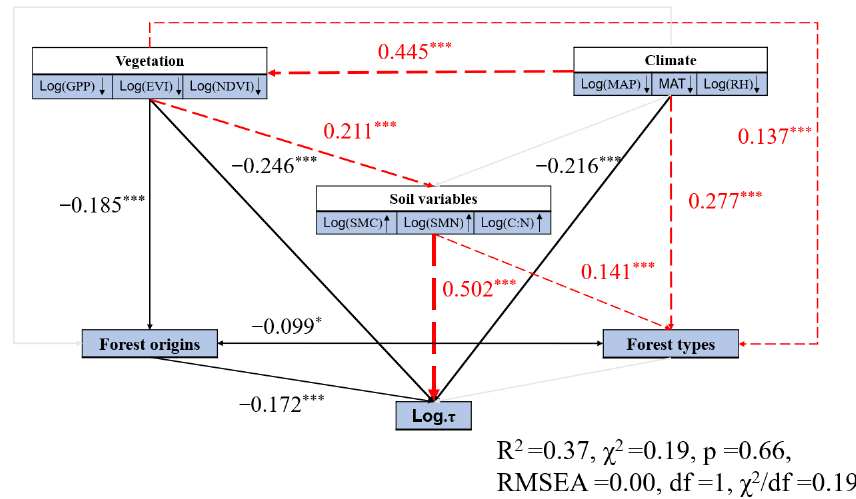
Figure 4. The main influencing factors of subsoil τ were obtained by the SEM model. The symbols “ ↑ ” and “ ↓ ” indicate a positive or negative correlation between environmental factors and subsoil τ . The red dotted line and the black solid line indicate positive and negative relationships, respectively. The gray line indicates that the relationship is not significant at the p = 0.05 level; the thickness of the line indicates the magnitude of the path coefficient. The number next to the arrow is the normalized path coefficient, indicating the effect size of the relationship. The goodness of fit statistics for the effect size model of the relationship are as follows: * p < 0.05, *** p < 0.001.